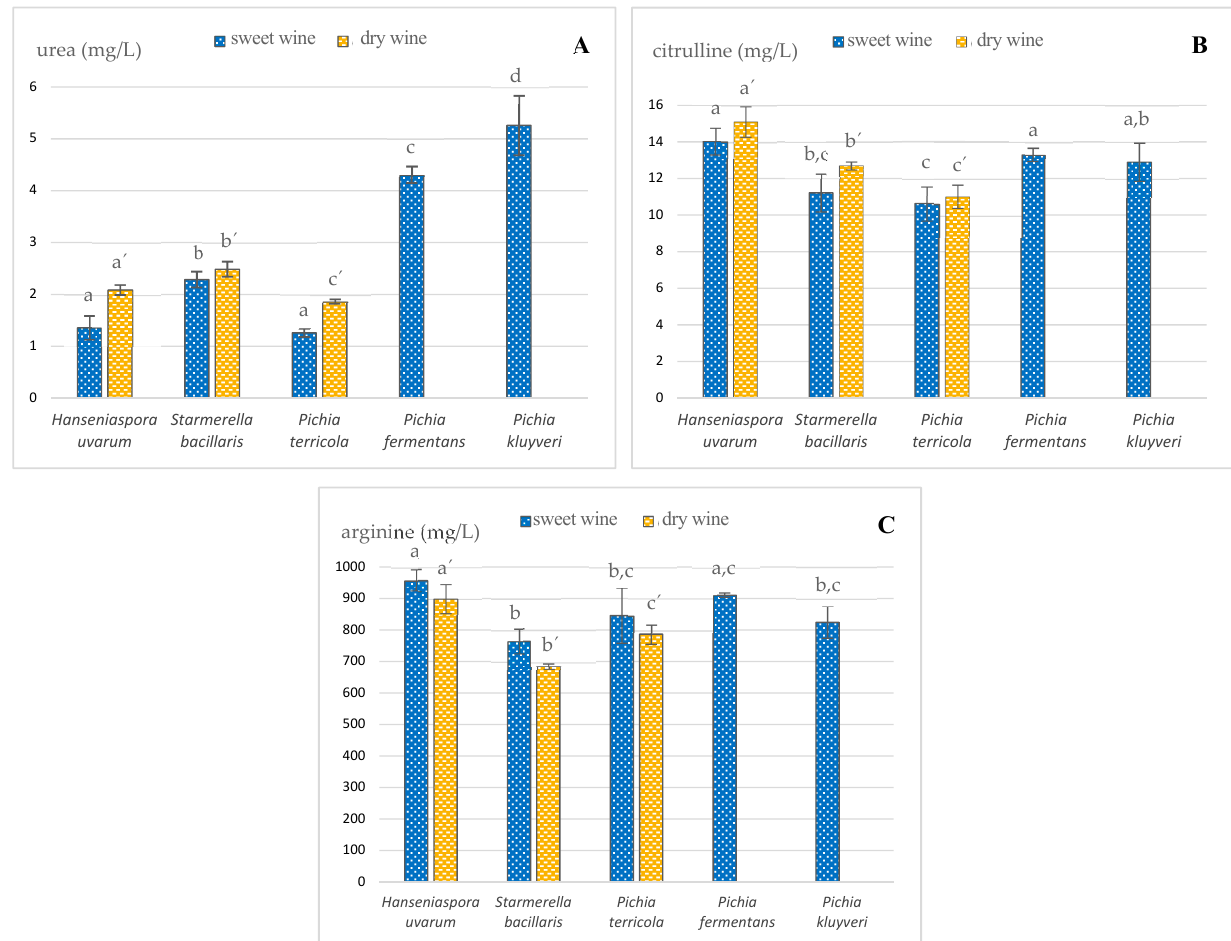
Figure 1. Impact of different indigenous non- Saccharomyces yeasts on the levels of ( A ) urea, ( B ) citrulline and ( C ) arginine found in sweet and dry wines sampled before alcoholic fortification; different letters within the same type of wine denote statistically significant differences ( p < 0.05) according to Holm–Sidak test. Data represent the average taken from duplicate experiments.